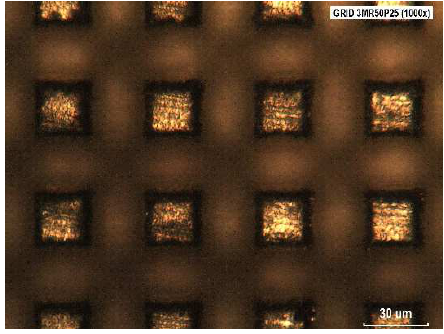
Fig. 1. Grid textured surface (grid) – fs laser, mag. 1000x